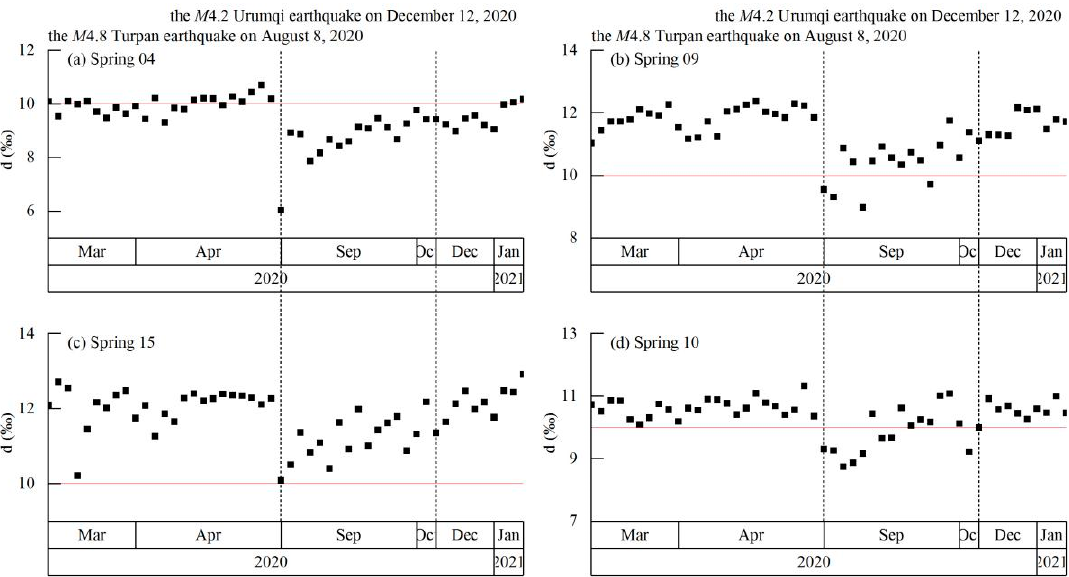
Figure 10. Time series of δ 2 H– δ 18 O deuterium excess (where d = δ 2 H – 8 × δ 18 O) of spring samples. The red line at ordinate = 10 shows the δ 2 H– δ 18 O deuterium excess of the global meteoric water line (GMWL). Black dashed lines denote earthquakes.